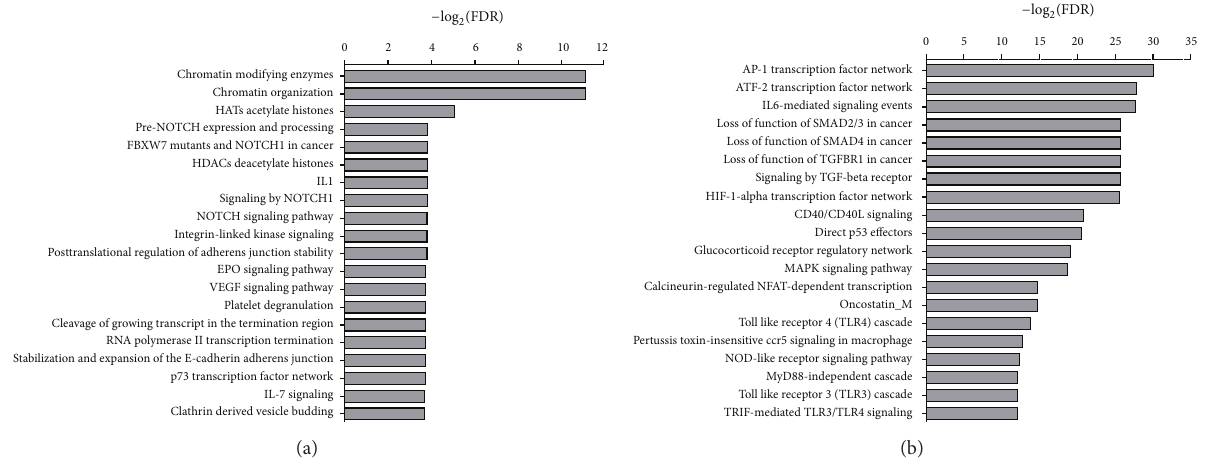
Figure 3: Pathway enrichment analysis with InnateDB. Differentially expressed genes from (a) GSE3397 or (b) GSE6802 were evaluated for overrepresentation in pathways annotated in databases as INOH, KEGG, NETPATH, PID NIC, and